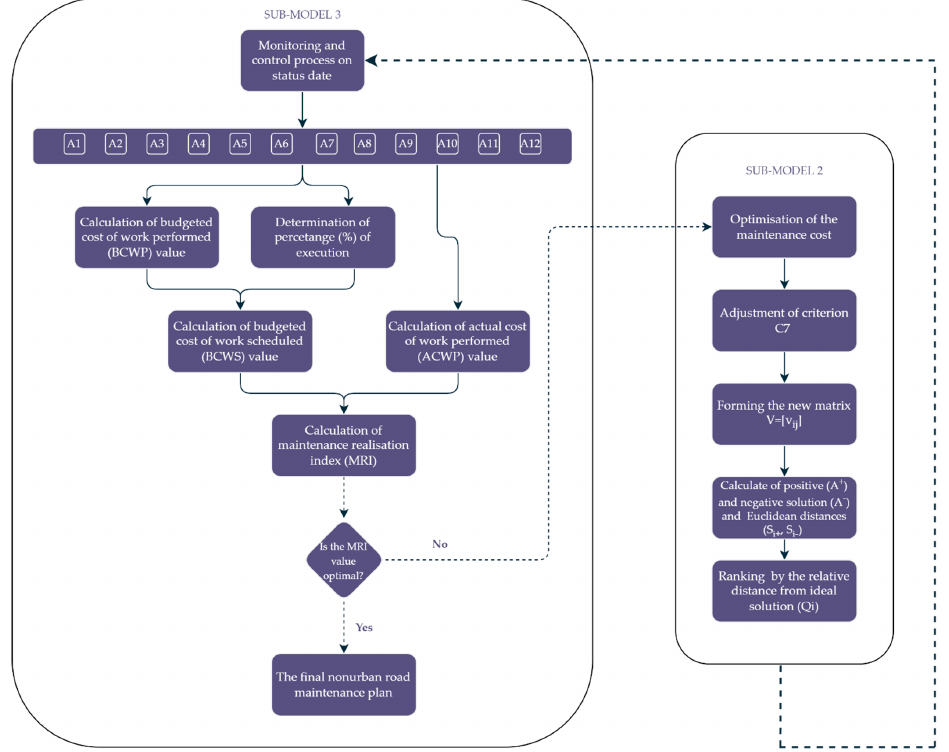
Figure 8. Interconnection between sub − model for monitoring and control and sub − model for priority ranking.